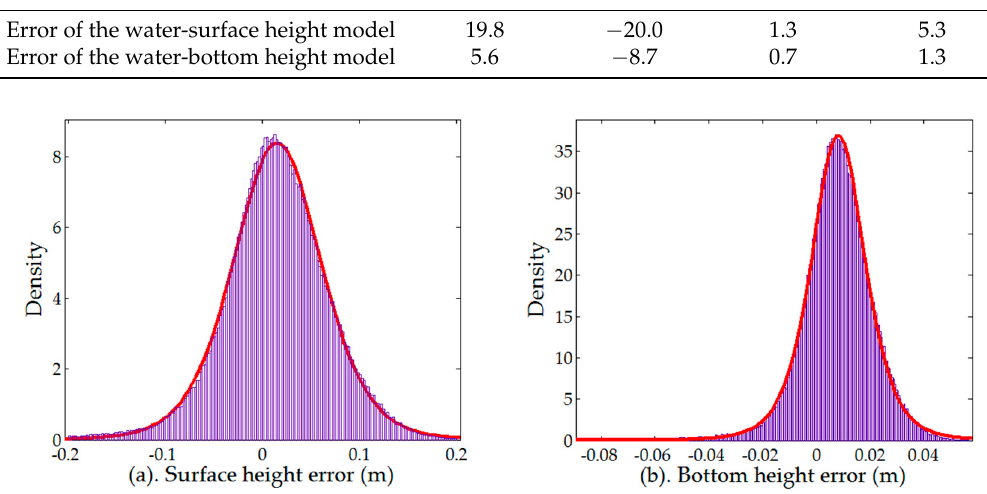
Figure 5. PDF curves of the height model errors: ( a , b ) show the PDF curves of the water-surface height and water-bottom height model errors,